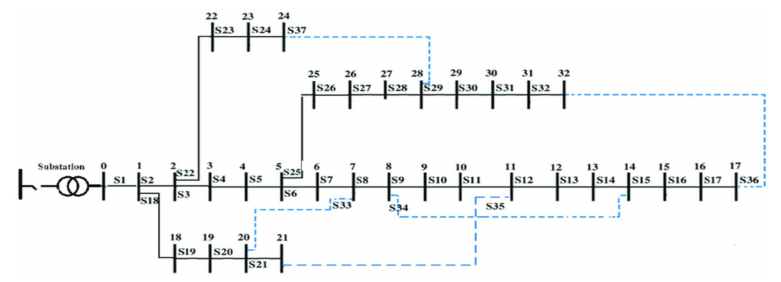
Figure 2. Single-line diagram of IEEE 33 Bus radial distribution system